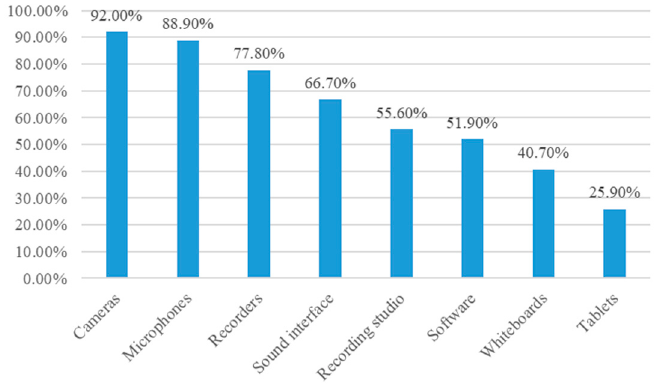
Figure 9. Endowment of HCM and ACS.